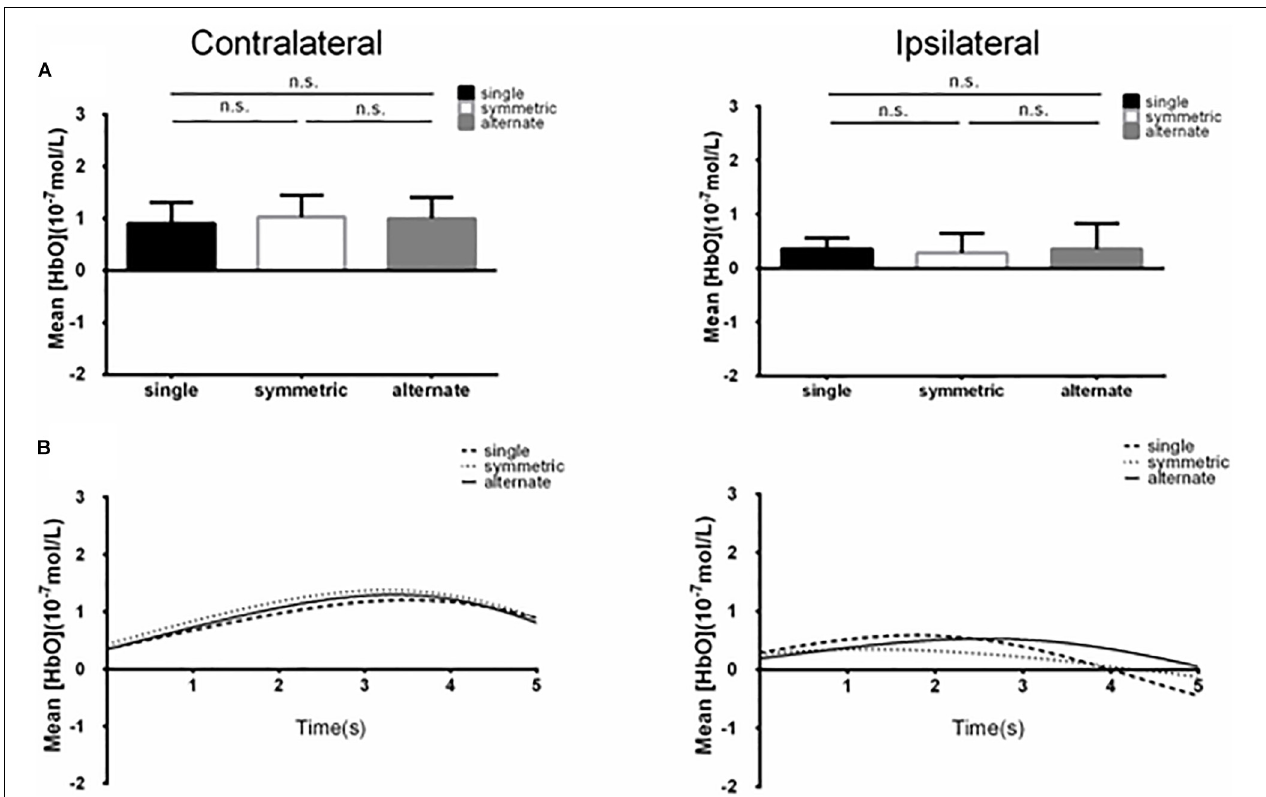
FIGURE 3 | (A) Summary of mean [HbO] for the side of the brain contralateral (left) and ipsilateral (right) to movement averaged across ROI-1 (channels 5 and 6) corresponding subjects, and times. n.s., p > 0.10. Error bar: standard error (B) [HbO] time course contralateral (left) and ipsilateral (right) to movement. Mean [HbO] values across two channels (ROI-1, channels 5 and 6) and corresponding subjects are shown.